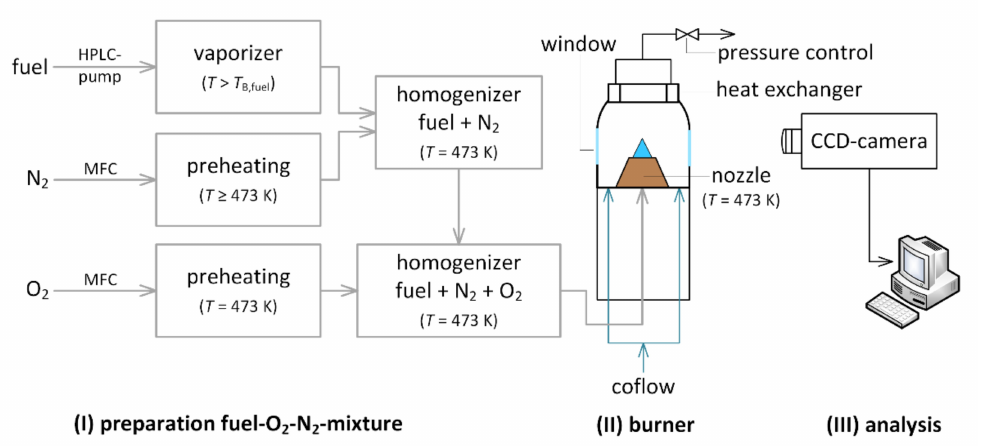
Figure 5. Scheme of the experimental set-up for the measurement of the laminar burning velocity of a conical laminar flame. The temperature of the nitrogen preheating depends on the final boiling of the fuel mixture but is at least 473 K; HPLC—high performance liquid chromatography, MFC—mass flow controller, T B,fuel —final boiling point of the fuel